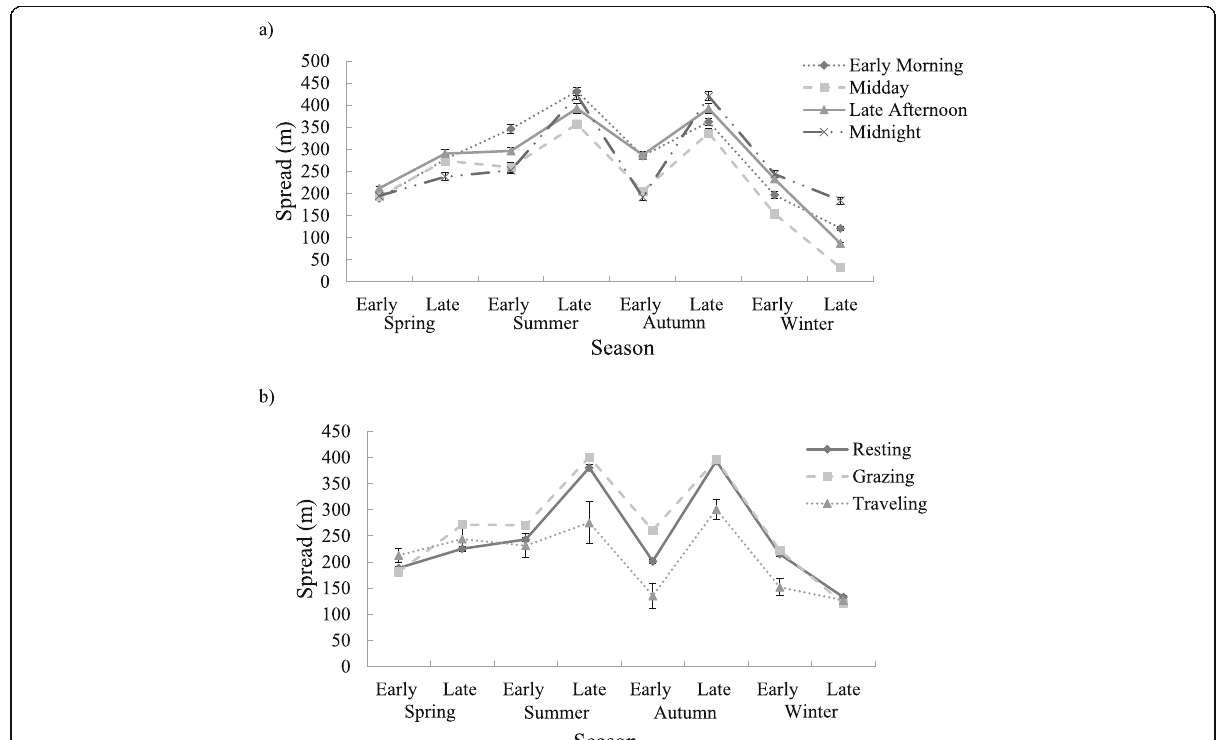
Fig. 6 Mean and standard error of the spread per period of the day ( a ) and activity ( b ) of a free-ranging cattle herd ( N = 11) during eight trials of 3 weeks from September 2007 to August